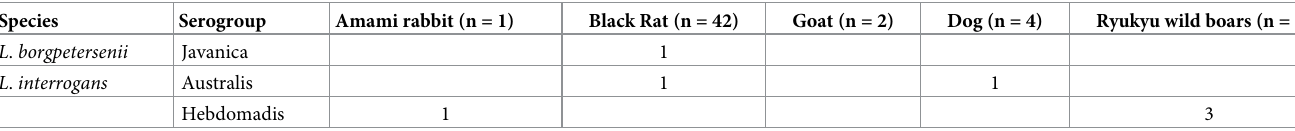
Table 1. Species and serogroups of Leptospira isolates obtained in this study. Species